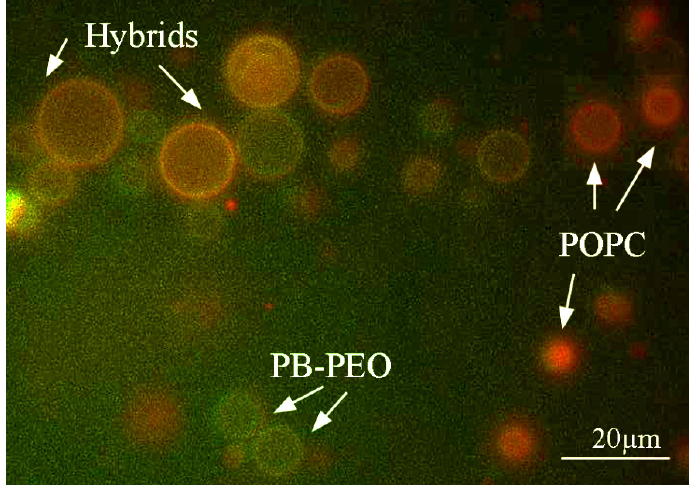
Figure 3. Hybrid giant unilamellar vesicles (GUVs) of PB-PEO/POPC (50:50) prepared by electroformation observed using fluorescence microscopy. Hybrid GUVs only form part of the GUV population. The green color indicates GUVs formed from PB-PEO, while red indicates POPC. Yellow indicates the presence of both, i.e. , hybrid